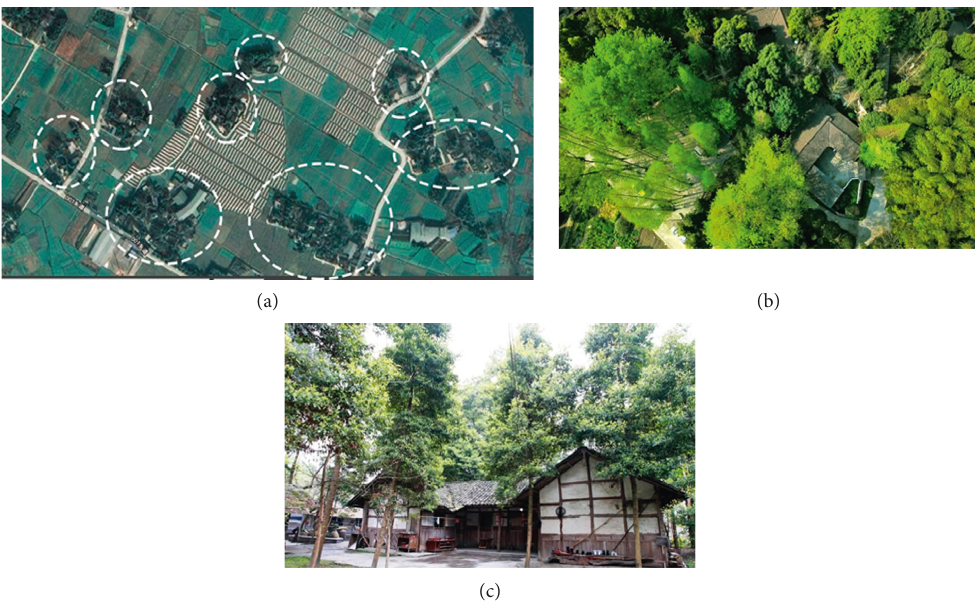
Figure 1: Linpan scene in Chengdu